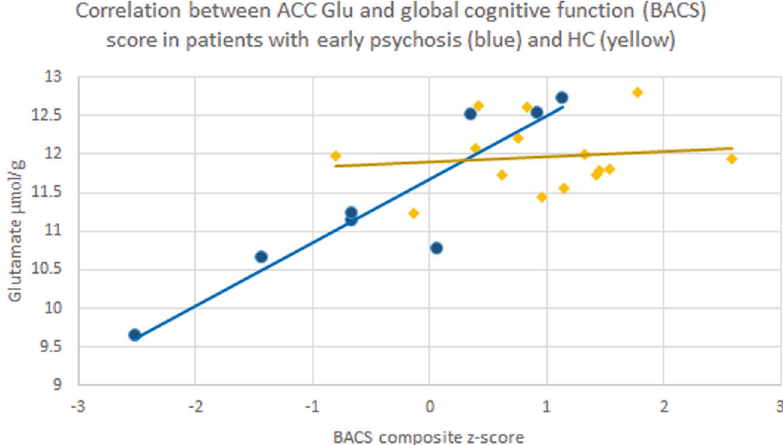
Fig. 3 Correlation between ACC glutamate concentration and BACS score. Correlation between individual glutamate (Glu) concentrations ( μ mol/g) in the ACC of patients with fi rst episode psychosis (blue), healthy controls (HC,yellow) and BACS composite z-score, representing global cognitive function; early psychosis r = 0.92, p = 0.001; HC r = 0.13, p =